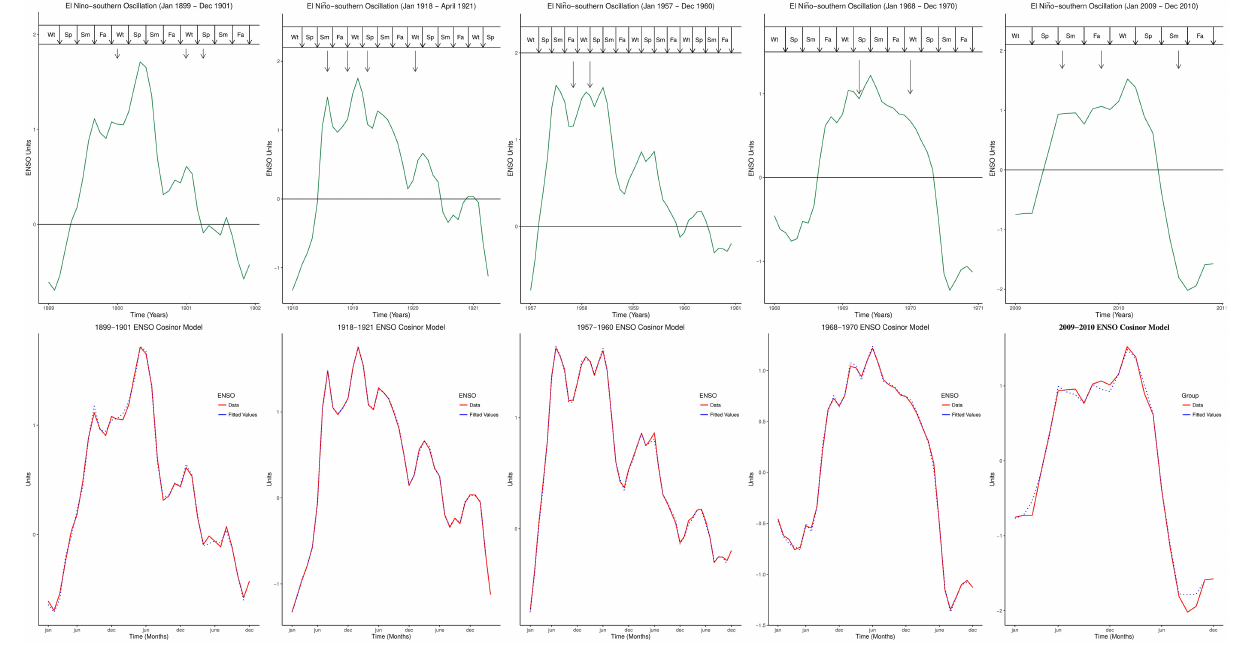
Frontiers in Environmental Science |